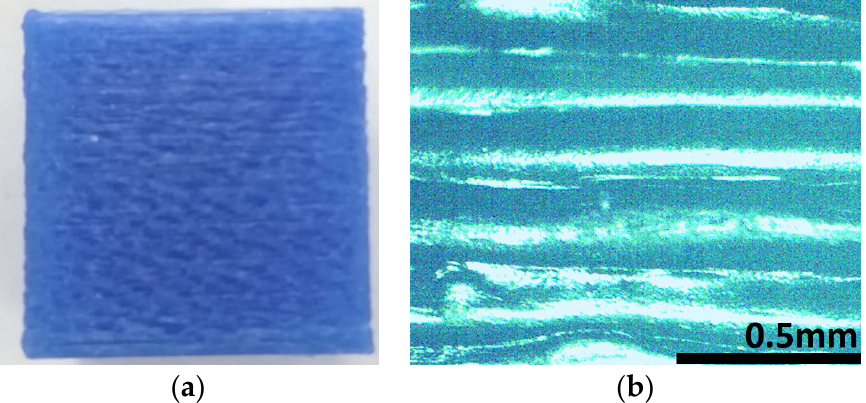
Figure 7. ( a ) 3D printed wax cube with visible ripples on the side surface and ( b ) magnified view of the surface.